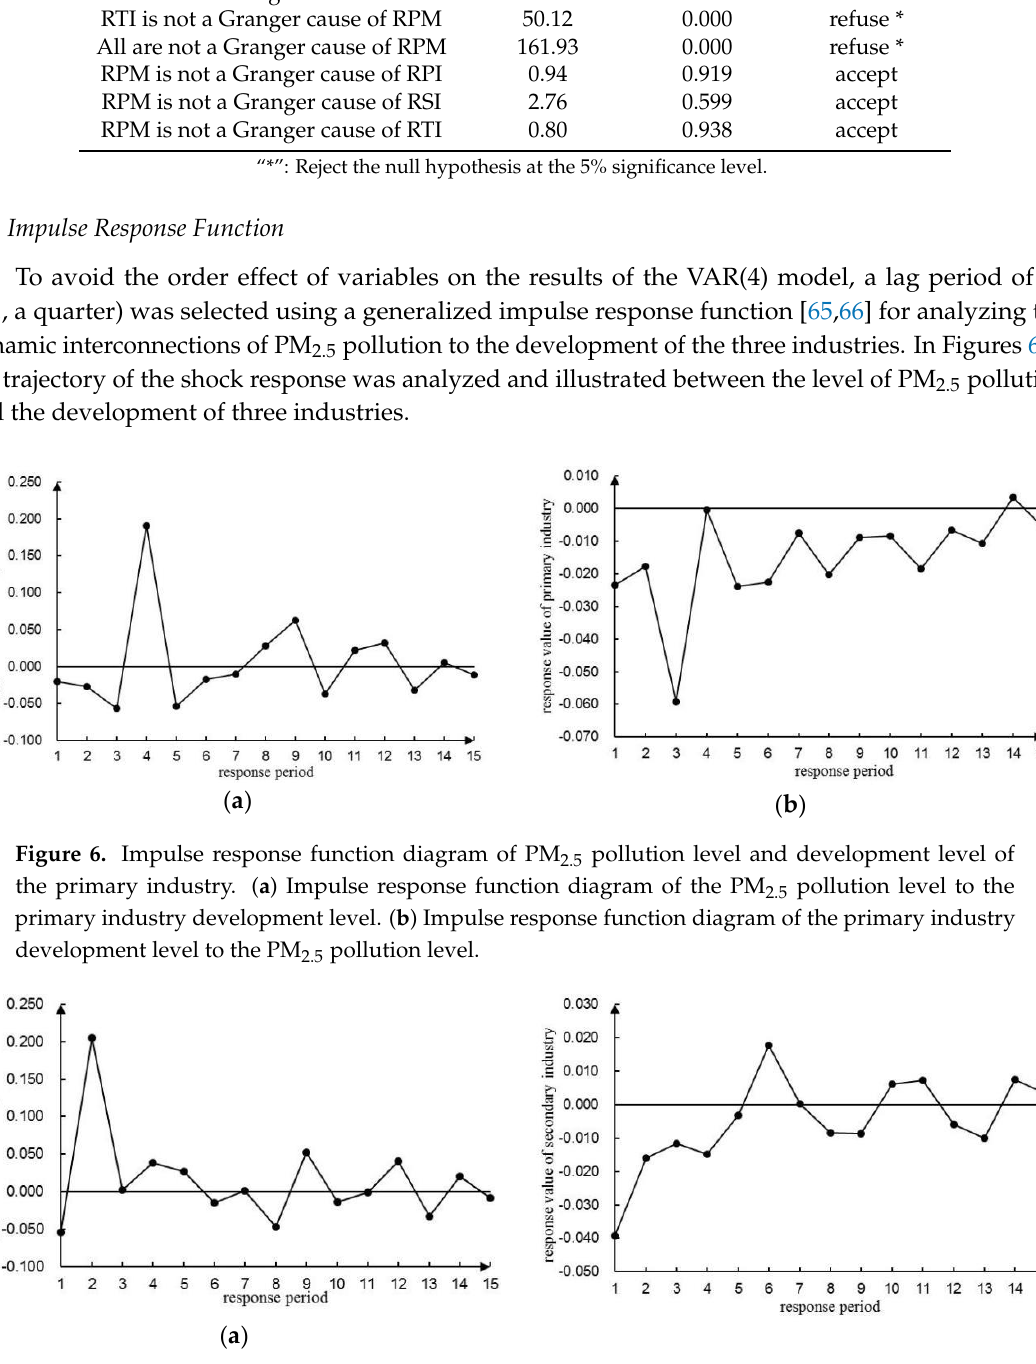
( b ) Figure 8. Impulse response function diagram of PM 2.5 pollution level and development level of the tertiary industry. ( a ) Impulse response function diagram of the PM 2.5 pollution level to the tertiary industry development level. ( b ) Impulse response function diagram of the tertiary industry development level to the PM 2.5 pollution level.